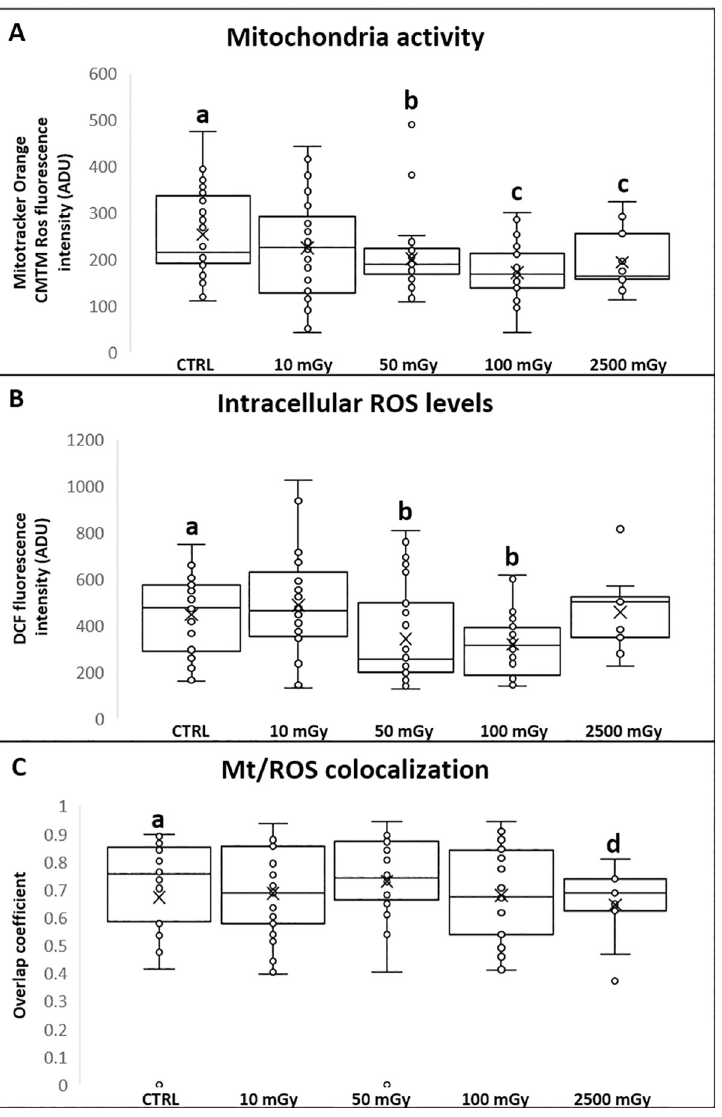
Fig 1. Effects of low-dose X-ray radiations before IVM on bioenergetic/oxidative status of matured oocytes. Mitochondria (mt) activity (panel A) and intracellular ROS levels (panel B) are expressed in arbitrary densitometric units (ADU) as means ± SD of MitoTracker Orange CMTMRos and DCF fluorescence intensity. Mitochondria/ROS colocalization (panel C) is expressed as means ± SD of overlap coefficient. One-way ANOVA followed by Dunnett’s post hoc test: a,b = P < 0.05, a,c = P < 0.01, a,d = P <